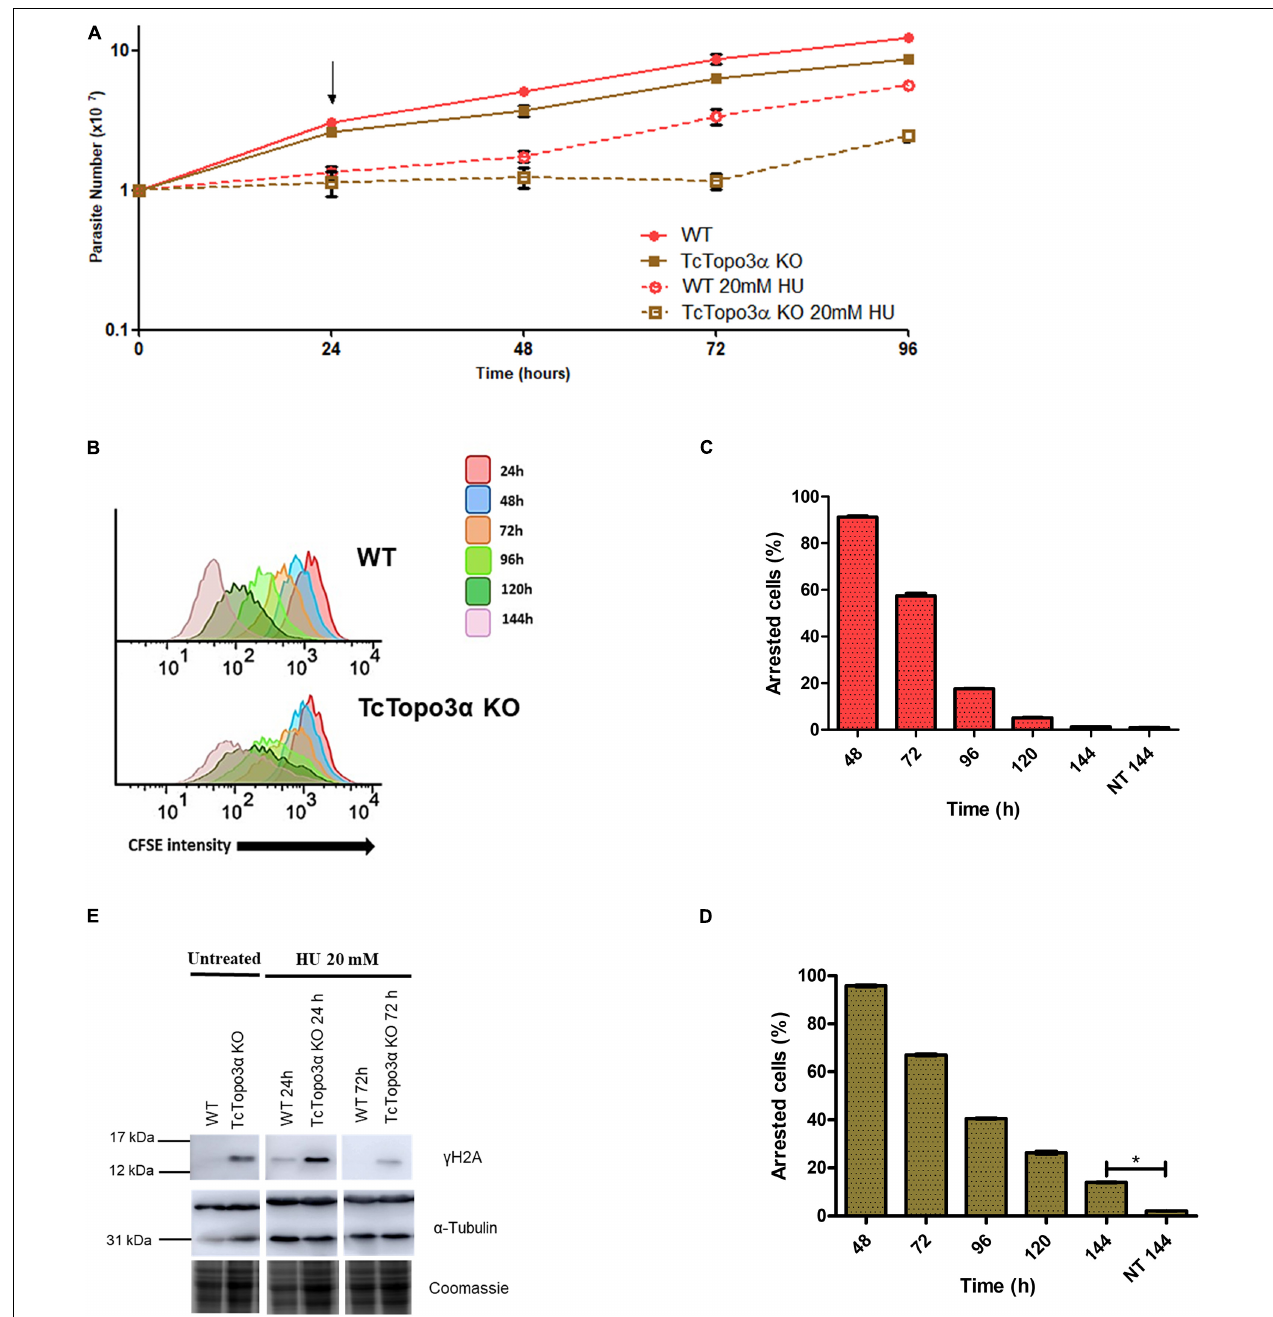
FIGURE 5 | The role of topoisomerase 3 α in the response to hydroxyurea (HU) treatment. (A) Growth curve after the treatment with 20 mM HU. The HU was kept in the LIT medium for 24 h. After that, the cells were washed and cultivated in a fresh medium. The cells were counted every day using a cytometry chamber and vital dye erythrosine. It shows that TcTopo3 α KO cells exposed to HU delayed resumption of growth in relation to WT cells. The arrow indicates the time when HU was removed from the medium. (B) Flow cytometry histograms of CFSE fluorescence intensity decay over time from epimastigotes exposed to 20 mM HU. Cells that have similar CFSE fluorescence intensity compared to the level of half median at time point of 24 h were considered as arrested. (C,D) The graph shows the percentage of arrested parasites determined by flow cytometry showing half of CFSE median intensity observed at 24 h of growth. The percentage of dormant parasites at 144 h from a culture without exposure to HU (NT 144 h) is shown for the sake of comparison. Representative results of three distinct experiments in three technical triplicates. Asterisks indicate statistically significant differences among groups ( p -value < 0.05). (E) Western blot to measure the levels on DNA damage after the treatment with 20 mM HU. The extracts were prepared at the indicated time points and were analyzed by Western blot with anti- γ H2A antibody. The anti- α -tubulin antibody was used as a loading control. Treatment with HU for 24 h increased levels of γ H2A in both parasites. The WT cells were able to repair their lesions at the time of 72 h, which did not happen with Topo3 α KO parasites. In the absence of HU, only TcTopo3 α KO cells exhibited bands for the phosphorylated histone.